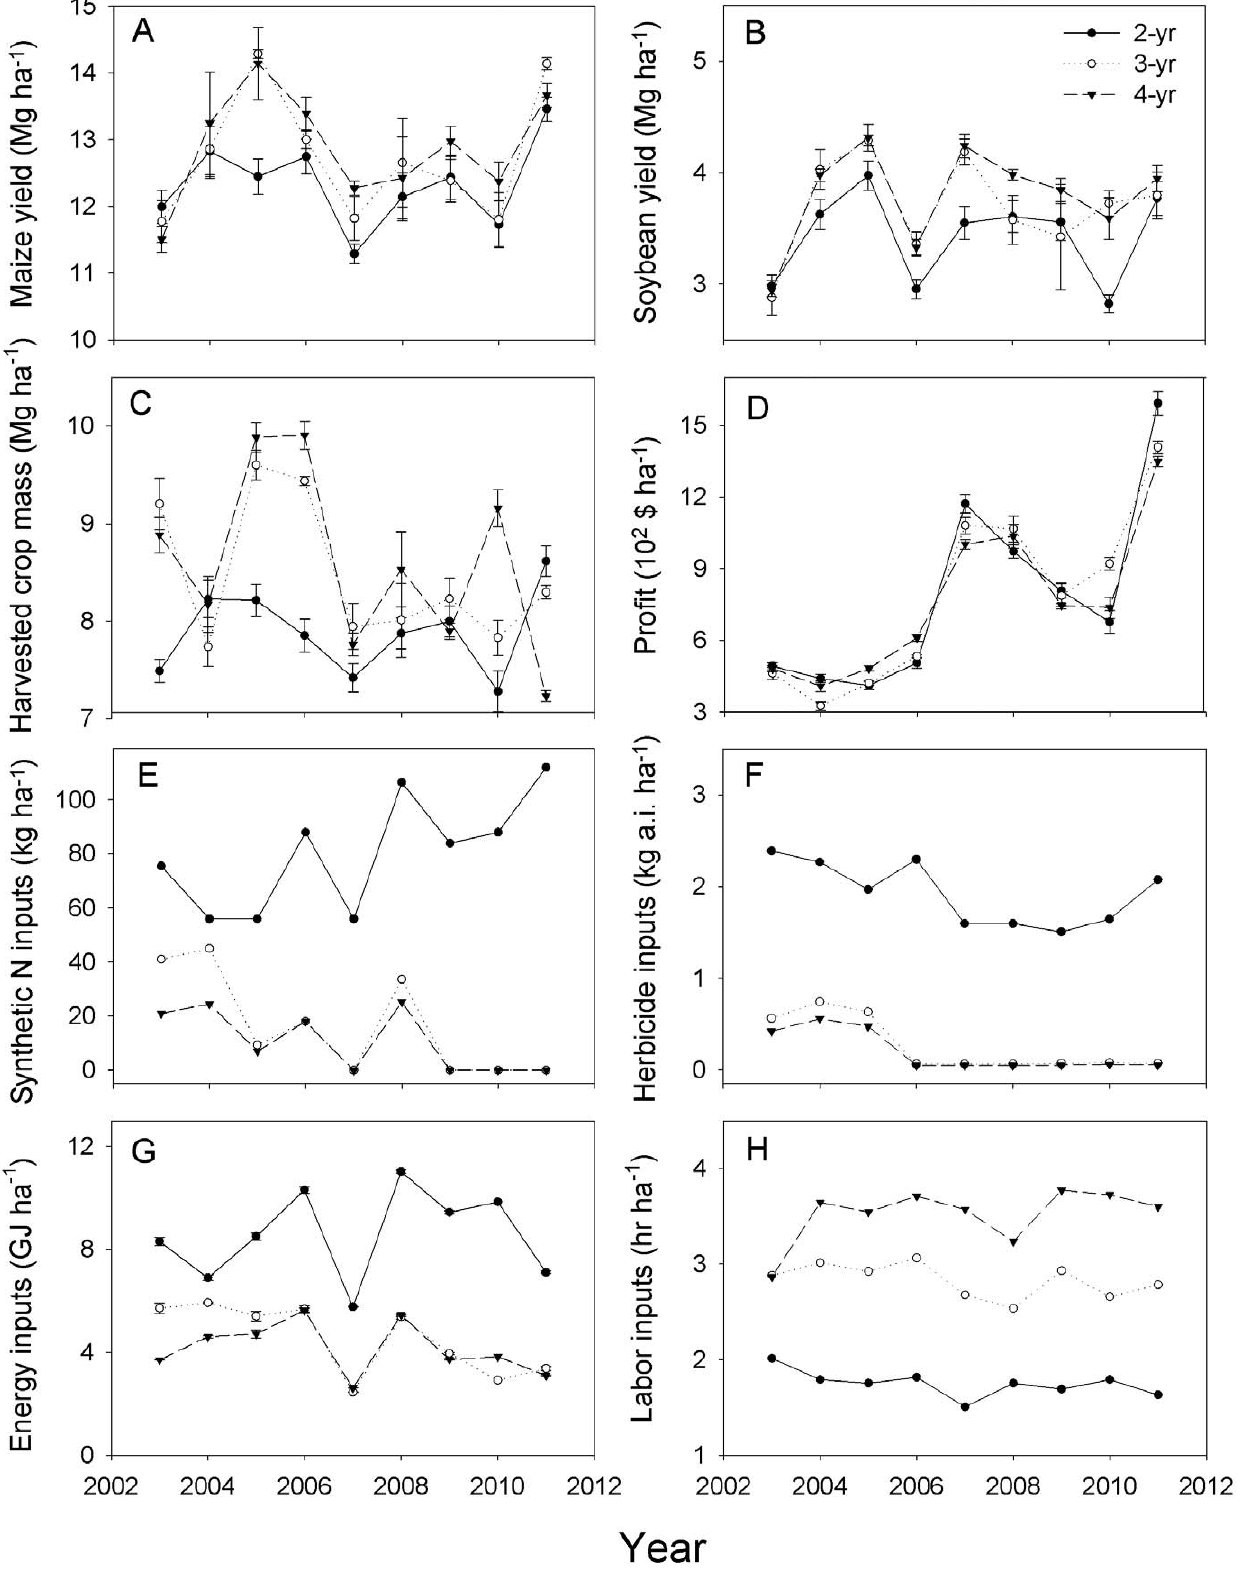
Figure 1. Cropping system performance over time. Annual performance of maize-soybean (2-yr), maize-soybean-small grain/red clover (3-yr), and maize-soybean-small grain/alfalfa-alfalfa (4-yr) cropping systems in Boone, IA, from 2003 to 2011. Performance metrics included: a) maize yield, b) soybean yield, c) rotation-level harvested crop mass, d) net returns to land and management, e) manufactured N fertilizer application rate, f) herbicide